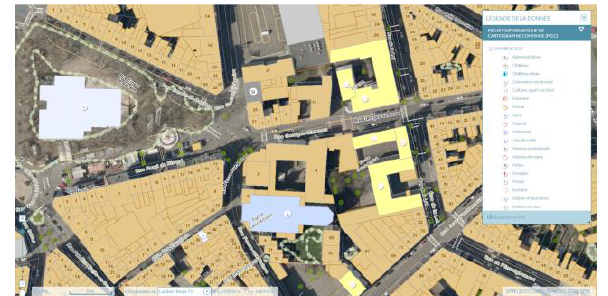
Figure 2. Extract of the PICC in the center of Liège